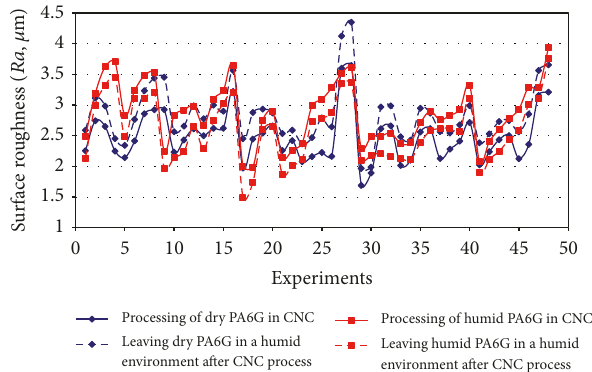
Figure 6: The effect of humidity on the average surface